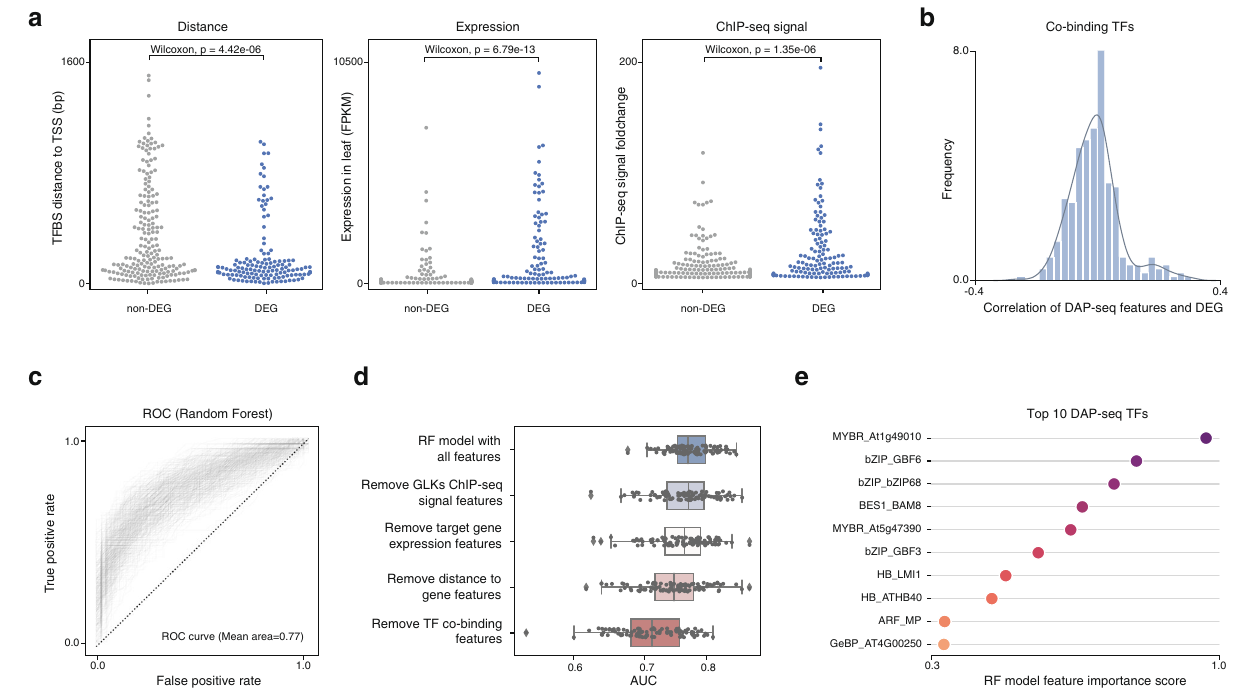
Fig. 7 | Machine learning model to predict target gene expression. a Different quantitative genome features of the differentially and non-differentially expressed GLK ChIP-seq target genes in the Arabidopsis GLK double mutant (Wilcoxon test, two-sided, n =328). b Histogram of Pearson correlation coef fi cient of DAP-seq TFs co-binding features and the GLK targets ’ DEG status. c ROC curves of the 500 random forest models. d Boxplot showing the area under the ROC curve (AUC) of